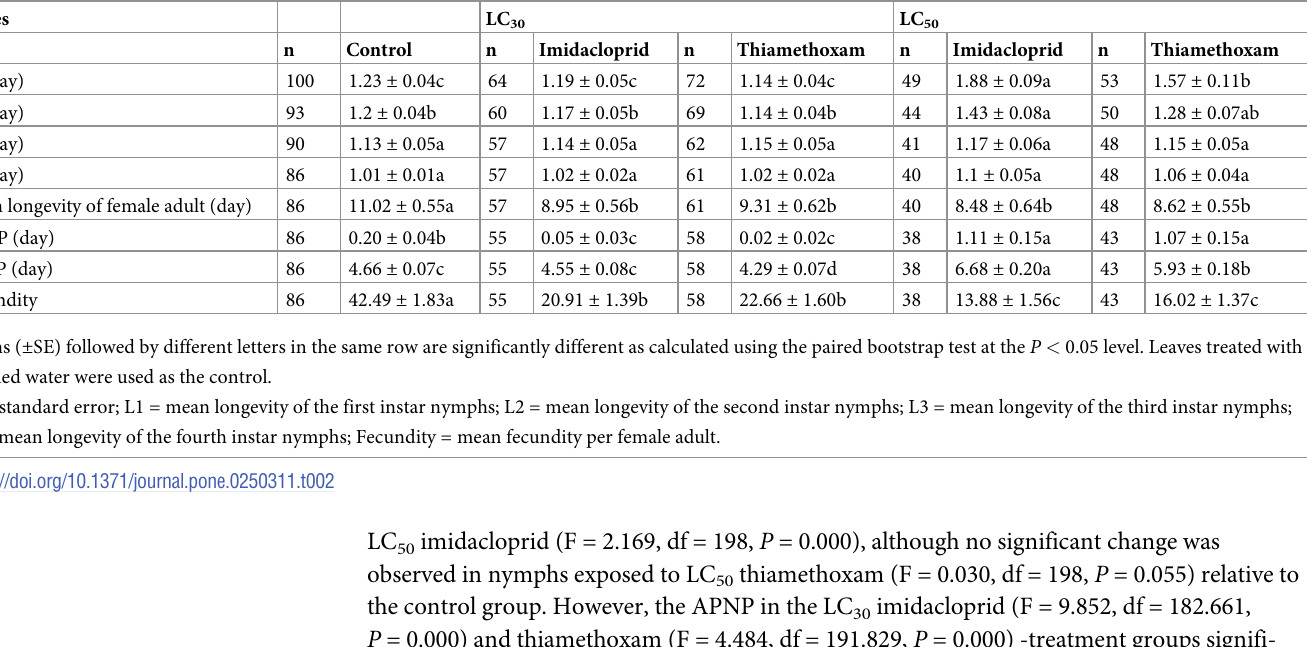
Table 2. Mean value ( ± SE) of life history parameters of A . glycines exposed to imidacloprid and thiamethoxam. Stages